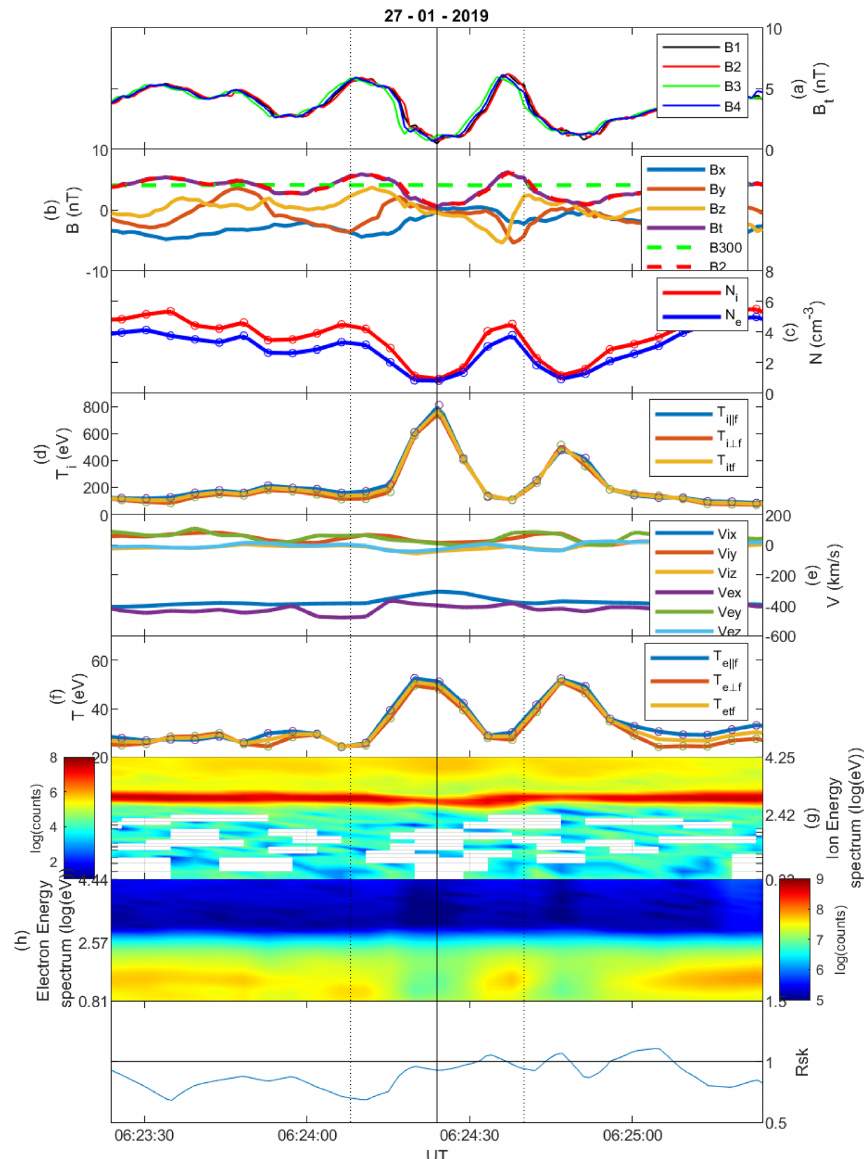
Figure 10. Linear magnetic hole on 27 January 2019, category sign change. Format as in Fig. 1.